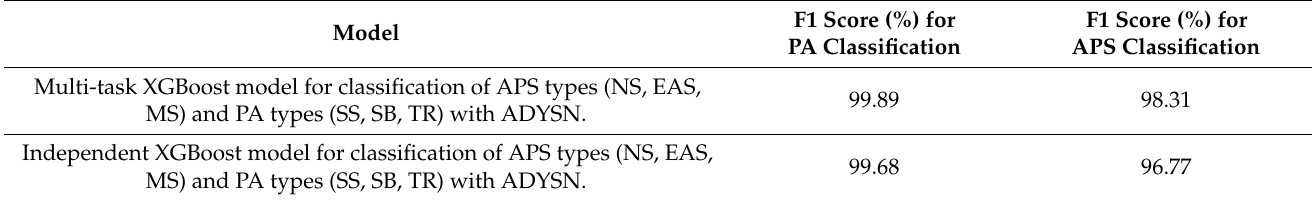
Table 7. F1 score for PA and APS Classification (XGBoost models).